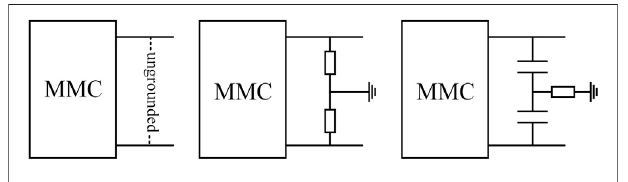
FIGURE 5 | MMC ’ s DC side grounding